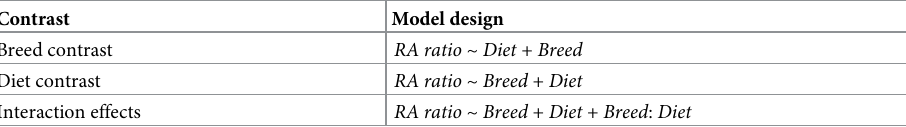
Table 1. DESeq2 differential abundance models for each contrast, with R